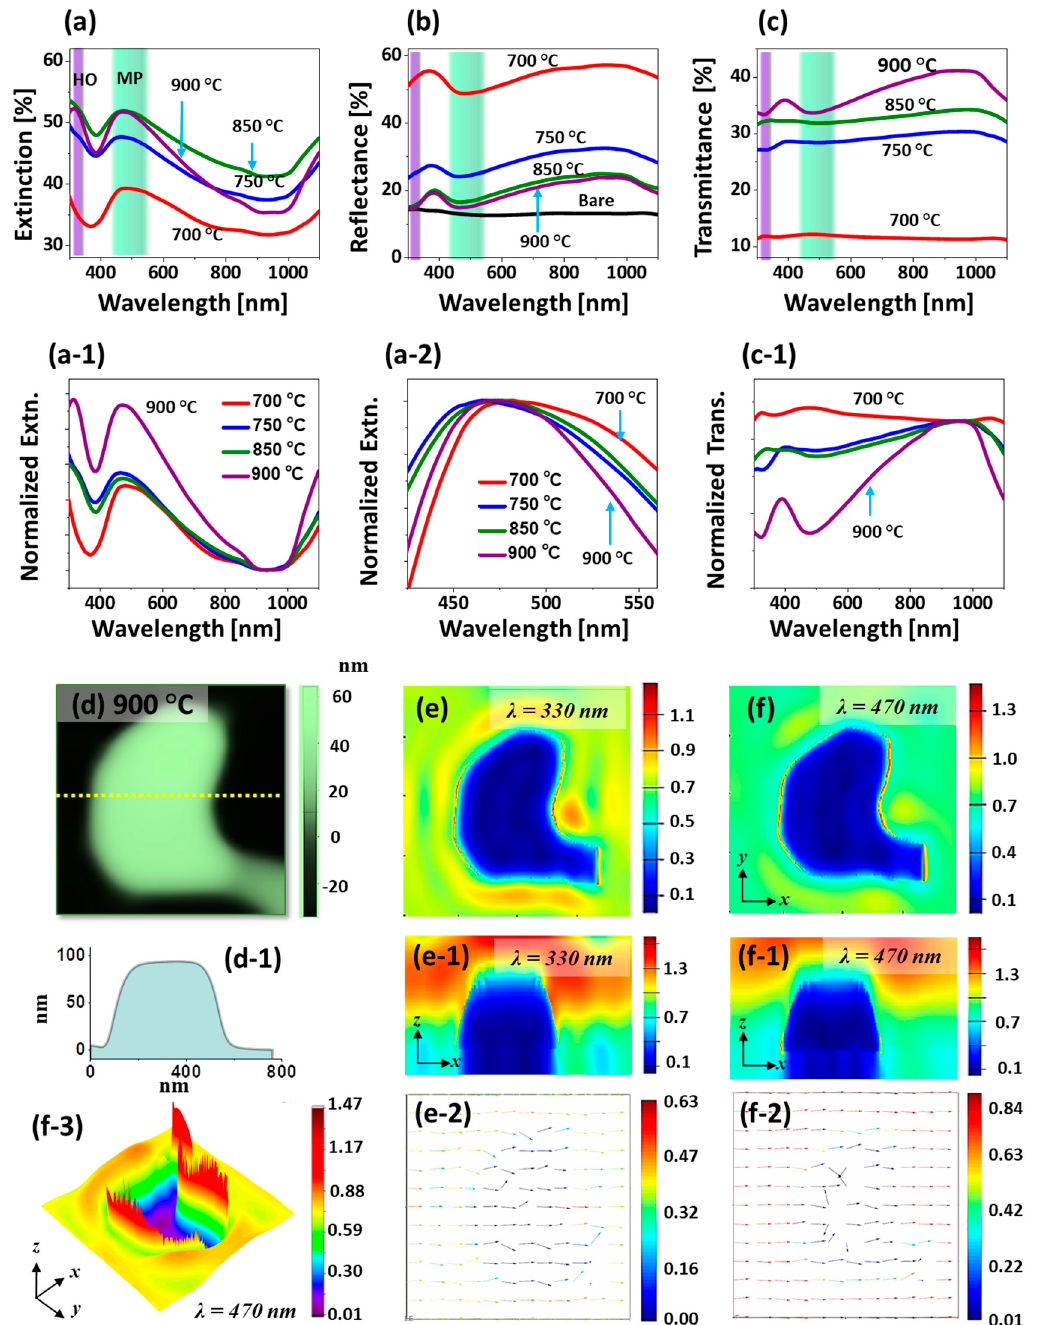
Figure 4. LSPR properties of Pt nanostructures fabricated with the In 30 nm / Pt 30 nm bilayers at various annealing temperature. ( a )–( a-2 ) Extinction, normalized extinction and magnified extinction spectra. ( b ) Reflectance spectra. ( c )–( c-1 ) Transmittance and normalized transmittance spectra. The color bands at the UV and VIS regions in ( a )–( c ) denote the higher order (HO) and multi-polar (MP) resonance modes respectively. ( d ) AFM images of typical Pt NPs. ( d-1 ) Cross-sectional line-profiles. ( e )–( f ) E-field profiles of NPs in xy-plane at di ff erent wavelengths. ( e-1 )–( f-1 ) E-field profiles in xz-plane. ( e-2 )–( f-2 ) E-field vector plots in xy-plane. ( f-3 ) 3D-view of the e-field